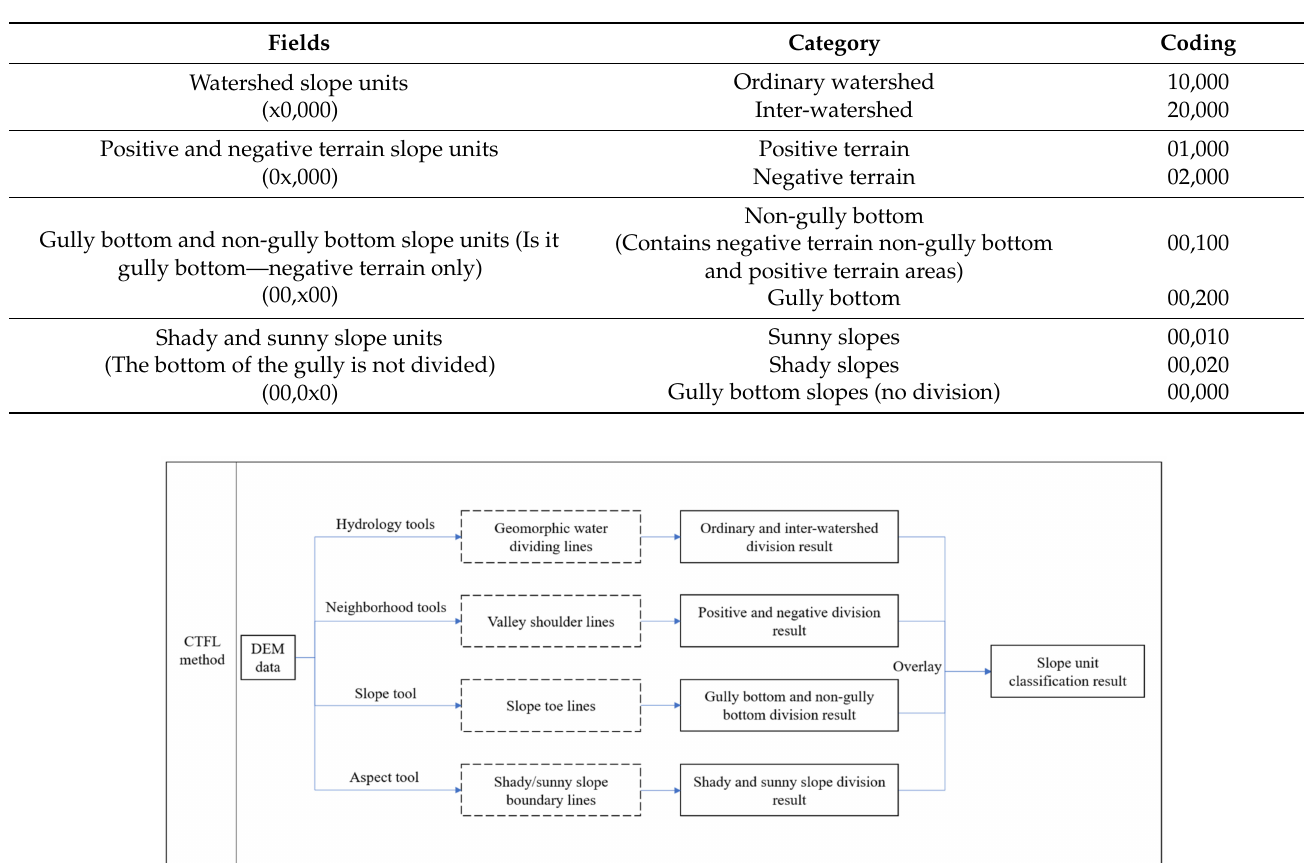
Table 1. The classification coding system of the slope unit.